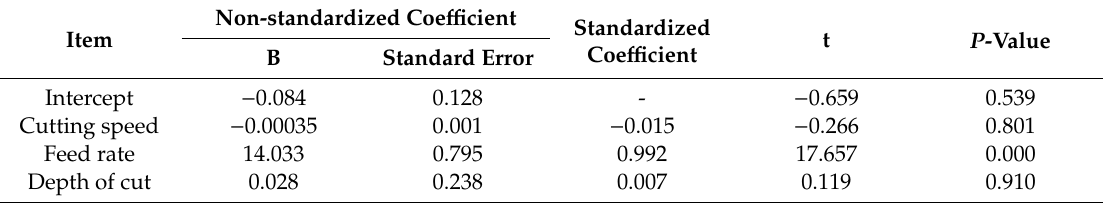
Table 7. Coe ffi cients of the multiple linear regression model of